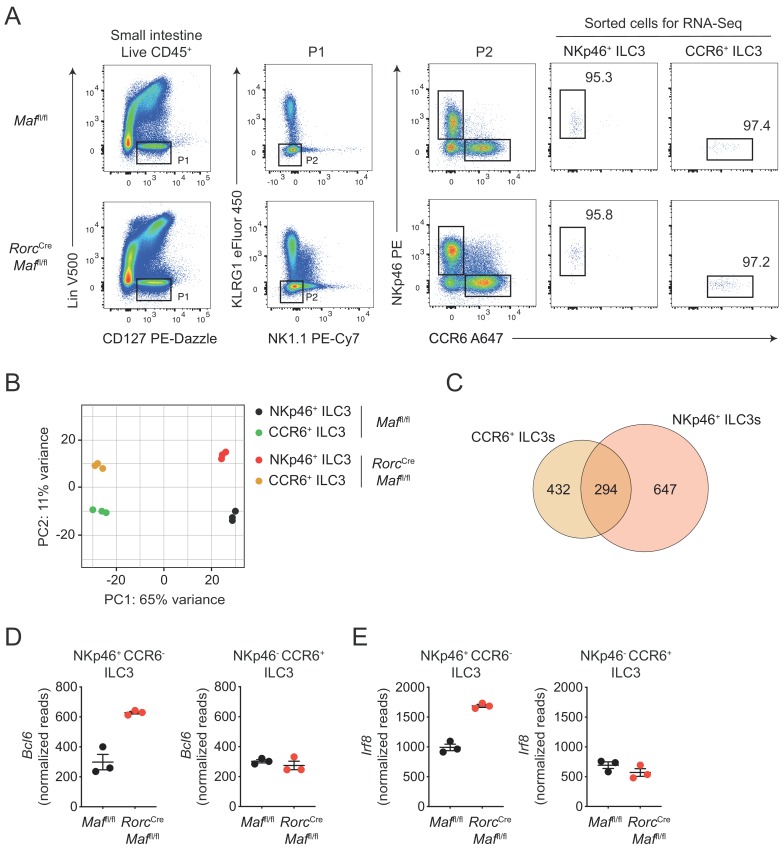
RNA-Seq analysis of intestinal NKp46+ CCR6- ILC3s and CCR6+ ILC3s.(A) Gating strategy for FACS-sorting of siLP ILC3s from RorcCre
Maffl/fl and Maffl/fl control mice for RNA-seq analysis. ILC3s were defined as viable CD45+ Lin- CD127+ KLRG1- NK1.1- cells. Lineage includes anti-CD5, anti-CD8α, anti-CD3, anti-Gr-1, anti-TCRγδ, anti-FcεRIα, anti-CD19 and anti-CD11c. (B) RNA-seq based principal component analysis (PCA) of FACS-sorted ILC3s. Each dot represents an individual biological replicate. (C) Venn diagram displaying the overlap between genes differentially expressed between c-Maf-deficient and control NKp46+ CCR6- ILC3s and CCR6+ ILC3s. (D, E) RNA-seq based expression of Bcl6 (D) and Irf8 (E) in c-Maf-deficient vs. control NKp46+ CCR6- ILC3s and CCR6+ ILC3s. Each dot represents an individual biological replicate.